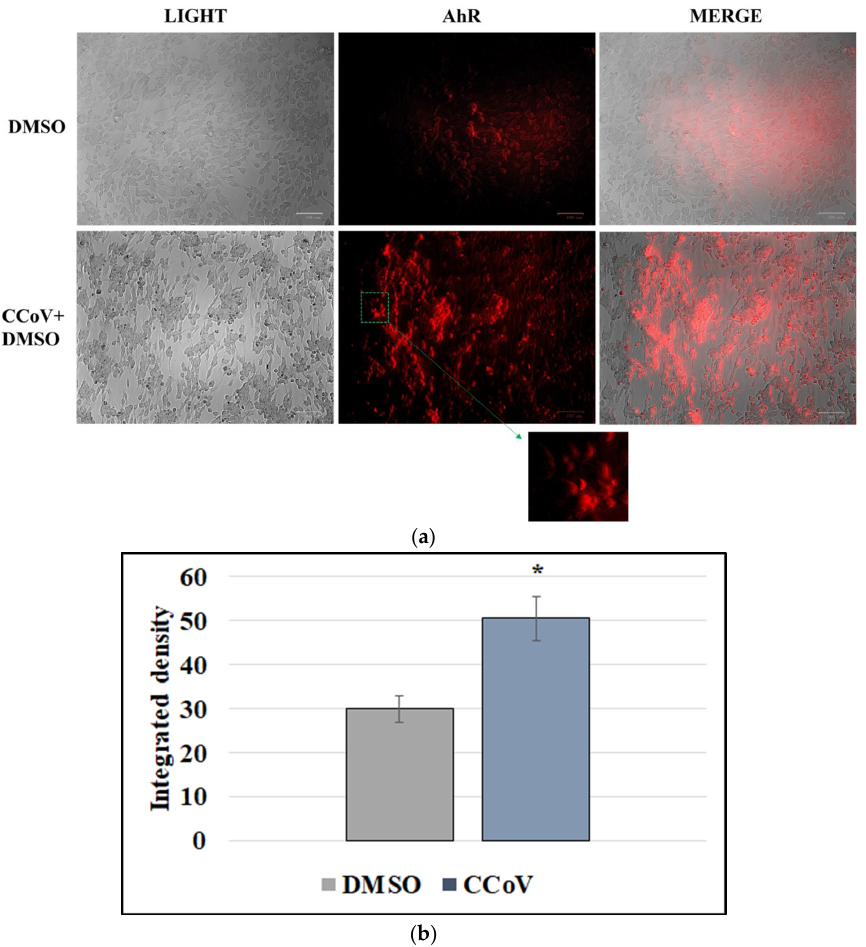
Figure 5. CCoV infection activates the expression of AhR in A72 cells. A72 cells were infected with CCoV at MOI of 0.05. At 24 h p.i., immunofluorescence staining for AhR was performed. ( a ) In CCoV-infected cells a significant increase in AhR expression was found. Scale bar 100 μ m. ( b ) Bars represent the mean ratio generated from the integrated density (product of the area and mean intensity of fluorescence) of the AhR expression during CCoV infection evaluated by ImageJ. Error bars represent standard deviation measurement. Significant differences between CCoV-infected cells and AhR-inhibitor-treated infected cells are indicated by probability p . * p < 0.05. 3.5. AhR Inhibitor Inhibits Both AhR and NP Expression during CCoV Infection in A72 Cells Simultaneously, the expression of AhR and NP during CCoV infection on A72 cells were tested. NP was expressed during CCoV infection, and we also found that there was a co-expression of NP and AhR in some merged images of A72 cells (Figure 6a-MERGE). Moreover, using AhR inhibitor CH223191 not only down-regulated the expression of AhR, but also of NP (Figure 6a). Those findings were confirmed by integrated density fluorescence measurement (Figure 6b,c).